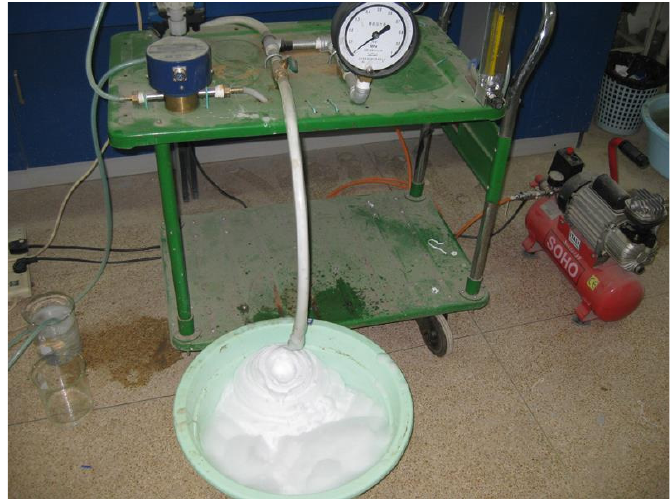
Figure 8. Image of a simulation device for a shield foam system. Table 5. Comparison of foaming agent half-life of the three foam